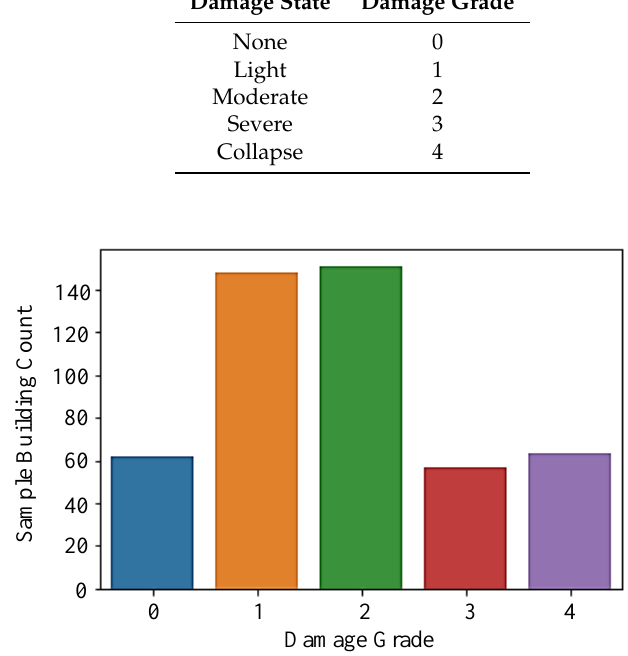
Figure 3. Number of buildings as per the damage